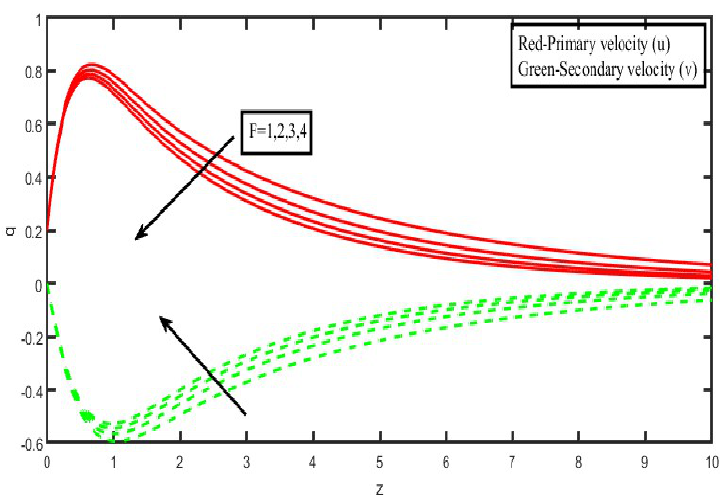
Figure 12. Velocity profiles for u and v for Rotation specification (R).